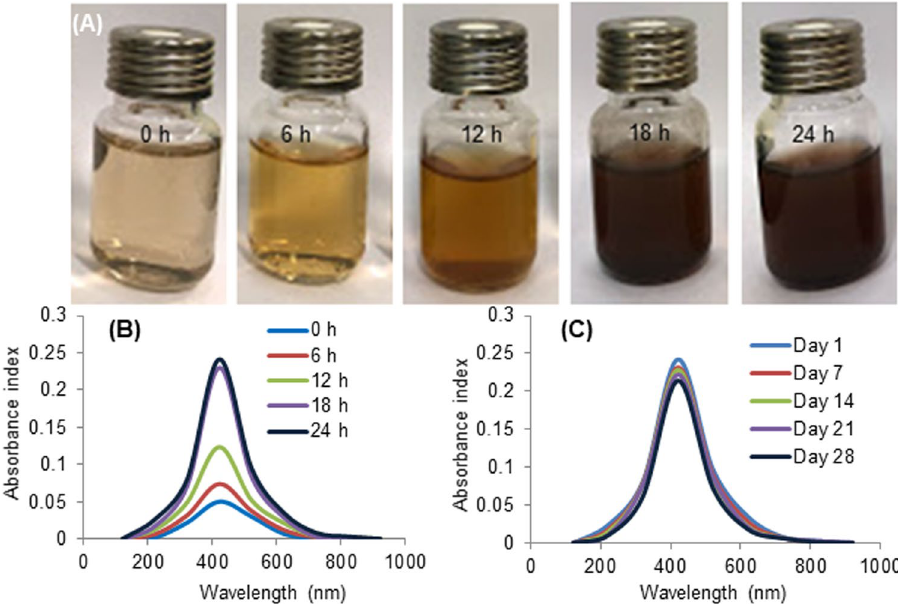
Figure 2. Phyto-fabrication of GA-AgNPs: ( A ) change in color during formation, ( B ) absorption spectra at various time intervals, and ( C ) on-shelf stability in UV–Vis spectroscopy